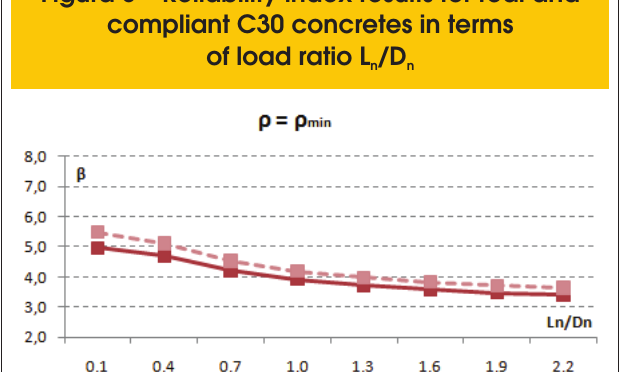
Figure 4. Results show that reliability indexes decrease as load ratios are increased. This behavior is well-known, and is known to be a consequence of using constant partial safety factors for loads ( and ), regardless of load ratios. Since the coefficient of variation (c.v.) of live load (0,25) is much larger than the c.v. g D g L of dead load (0,10), as the live load increases proportionally to the dead load, contribution of live load increases and reliability indexes are reduced.